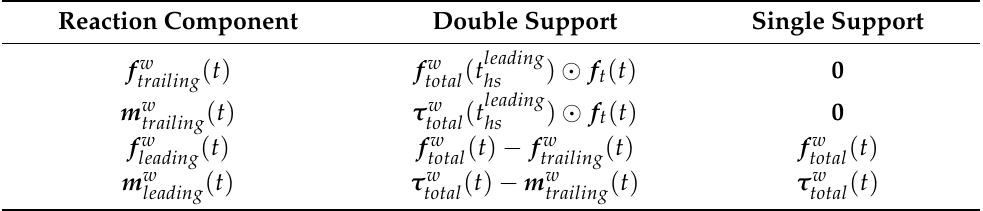
Table 1. According to the gait phase, classification of calculations for determining the forces and moments applied on the leading and trailing legs. During the single support phase, the GRF&M of the limb in contact with the ground are equal to the total external force f w Whereas, during the double support phase, the results are distributed between the two legs using the transition functions f t ( t ) described by [18]. The